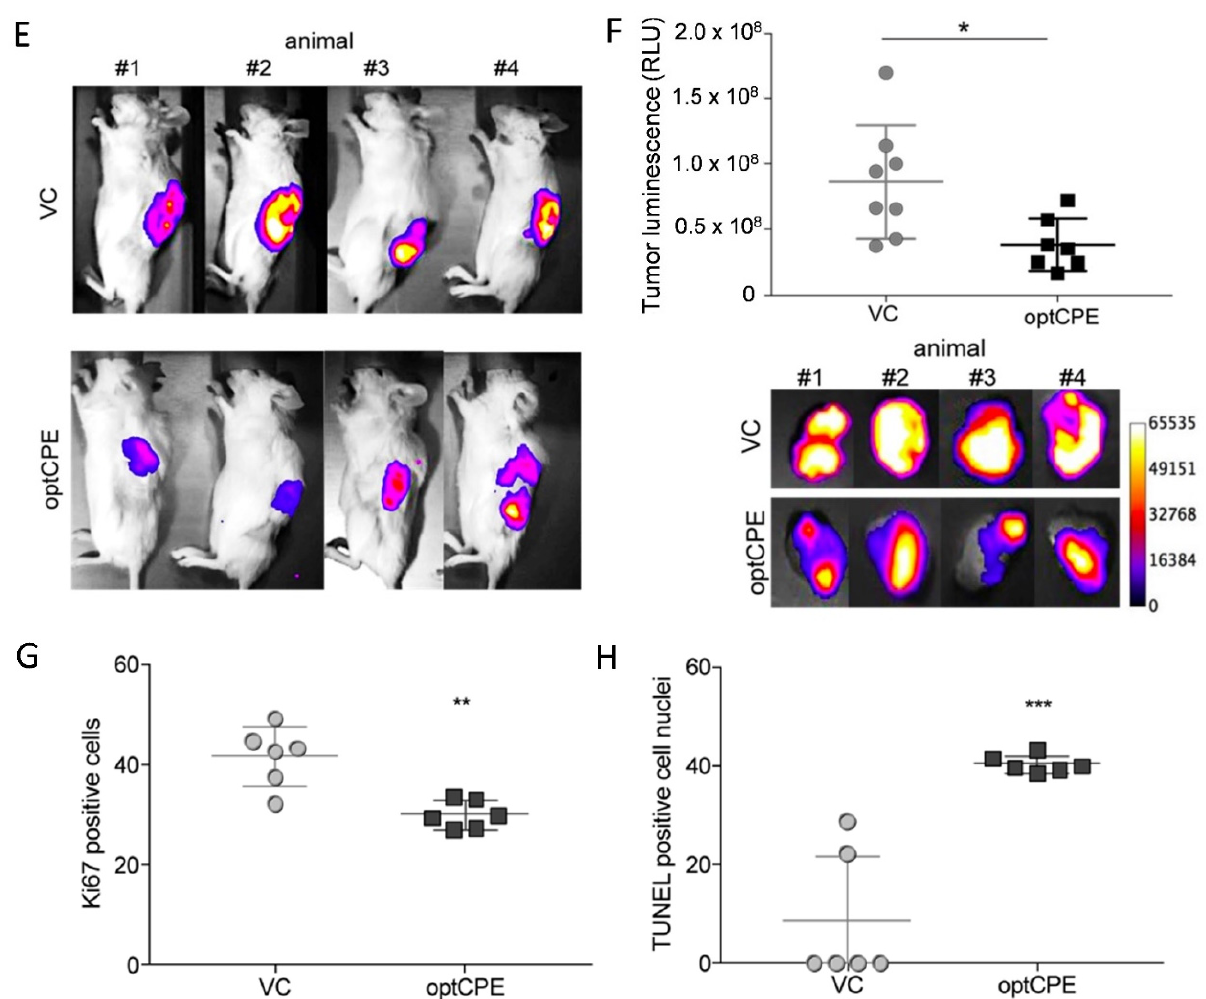
Figure 7. In vivo optCPE gene therapy in patient derived xenograft (PDX) models of PC. ( A ) Claudin3/4 expression analysis in 21 PC patient derived xenograft (PDX) models at mRNA and protein level (Figure S9). ( B ) Histopathology of primary and xenograft tissue show similar histological appearance in representative models (upper two rows). Representative images of Cldn3/4 expression (brown staining) in Panc9699, Panc9996, Panc10991, Panc11074 and Panc11495 PDX tumors ( C ) in optCPE non-viral jet-injection (performed 21 days after PDX derived cell injection) transfected Panc12536/eGFP-Luc- bearing mice significant antitumoral activity was observed. Significantly decreased tumor bioluminescence and ( D ) tumor growth was determined in optCPE-expressing tumors compared to empty vector control (VC). ( E ) In optCPE-transfected tumors reduced luminescence was measured compared to respective vector controls (VC), shown in representative images. ( F ) Significant reduction of viability in optCPE-transfected tumors, determined by quantification of ex vivo bioluminescence of tumors (representative bioluminescence images, lower panel). ( G ) The intratumoral optCPE gene transfer led to significantly reduced Ki67 reactivity within tumor tissue compared to VC treated tissue. ( H ) In optCPE-transfected Panc12536/eGFP-Luc PDX tumors the TUNEL assay revealed significantly increased number of TUNEL positive nuclei compared to VC-transfected tumors. (* p < 0.05; ** p < 0.01: *** p <